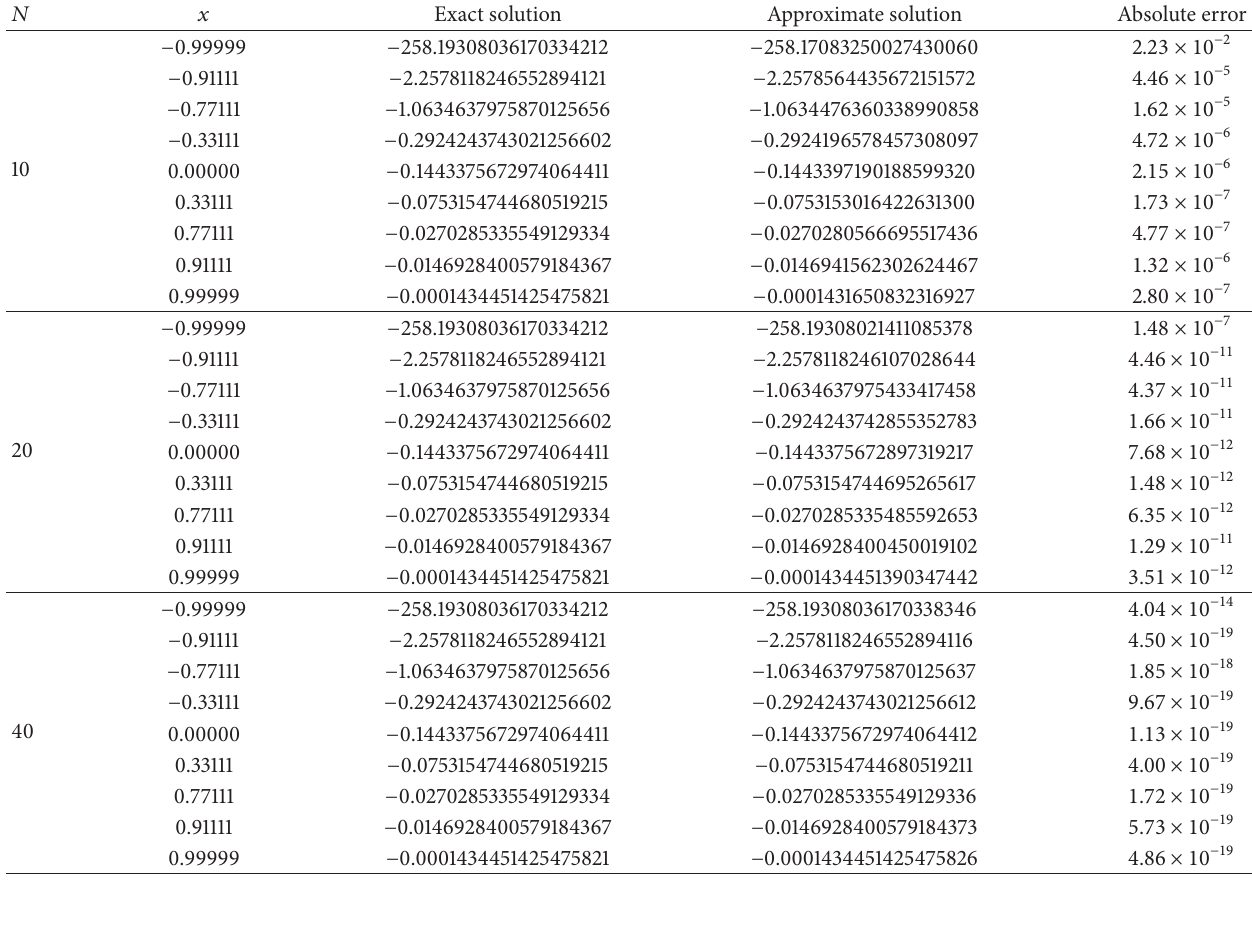
Table 3: Results of HSIs for 𝑤 1 (𝑡) .